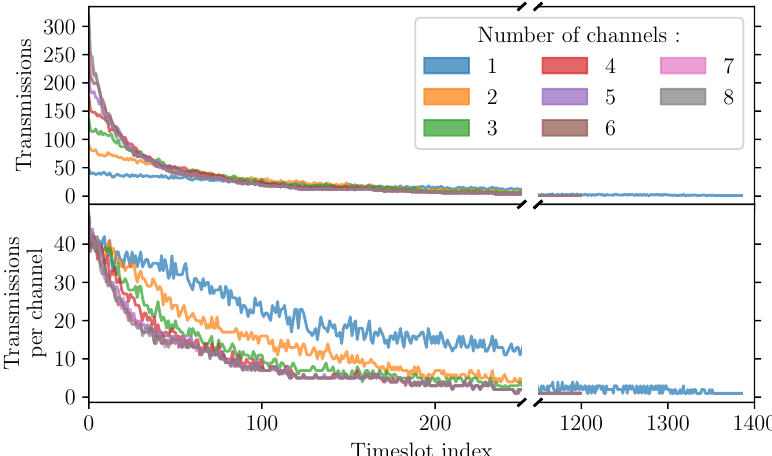
Figure 22. Number of transmissions per timeslot and maximum number of transmissions per channel and timeslot. Note the split x-axis and different x-axis scales.